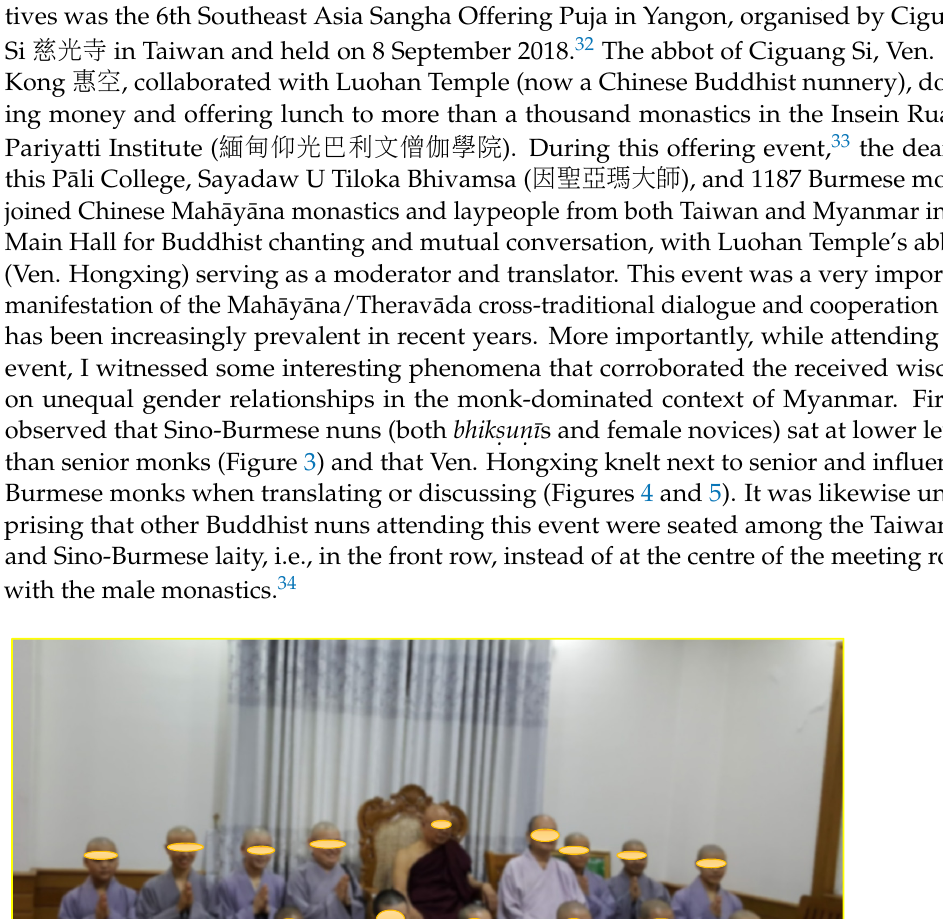
Figure 4. Ven. Hongxing kneeling next to influential senior Burmese monks during an event (Source: Author).